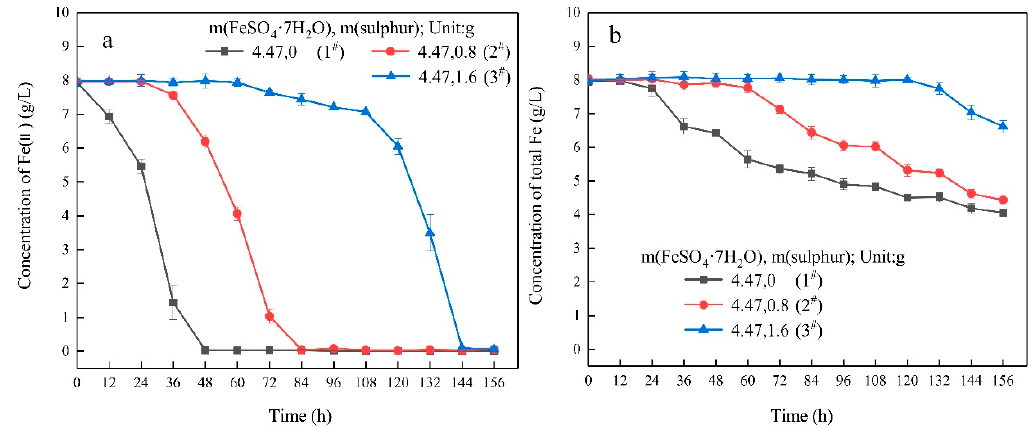
Figure 2. A graph of ferrous iron concentrations ( a ) and total iron concentrations ( b ) over time from experimental systems supplemented with ferrous.